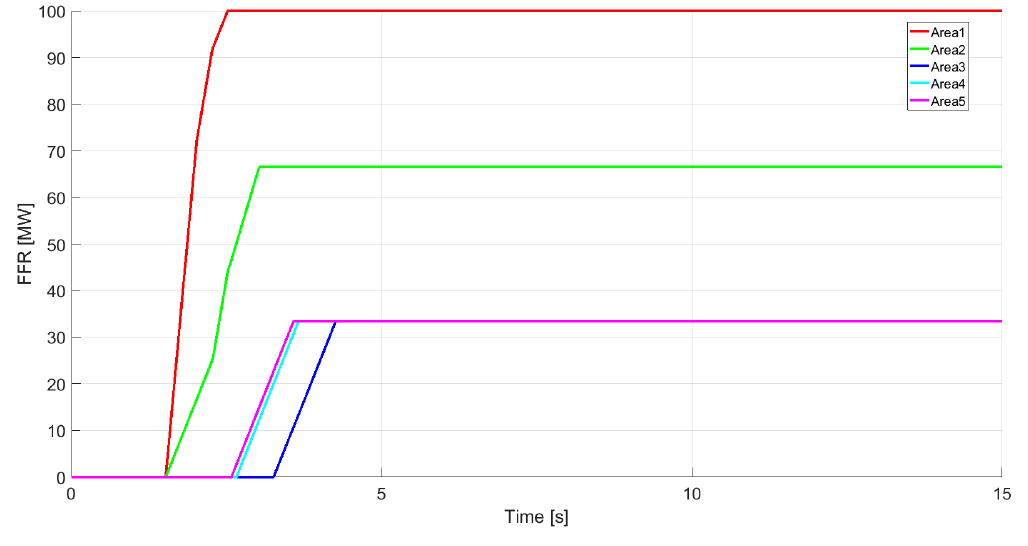
Figure 22. The RoCoF at generator buses after disturbance in Area 1.